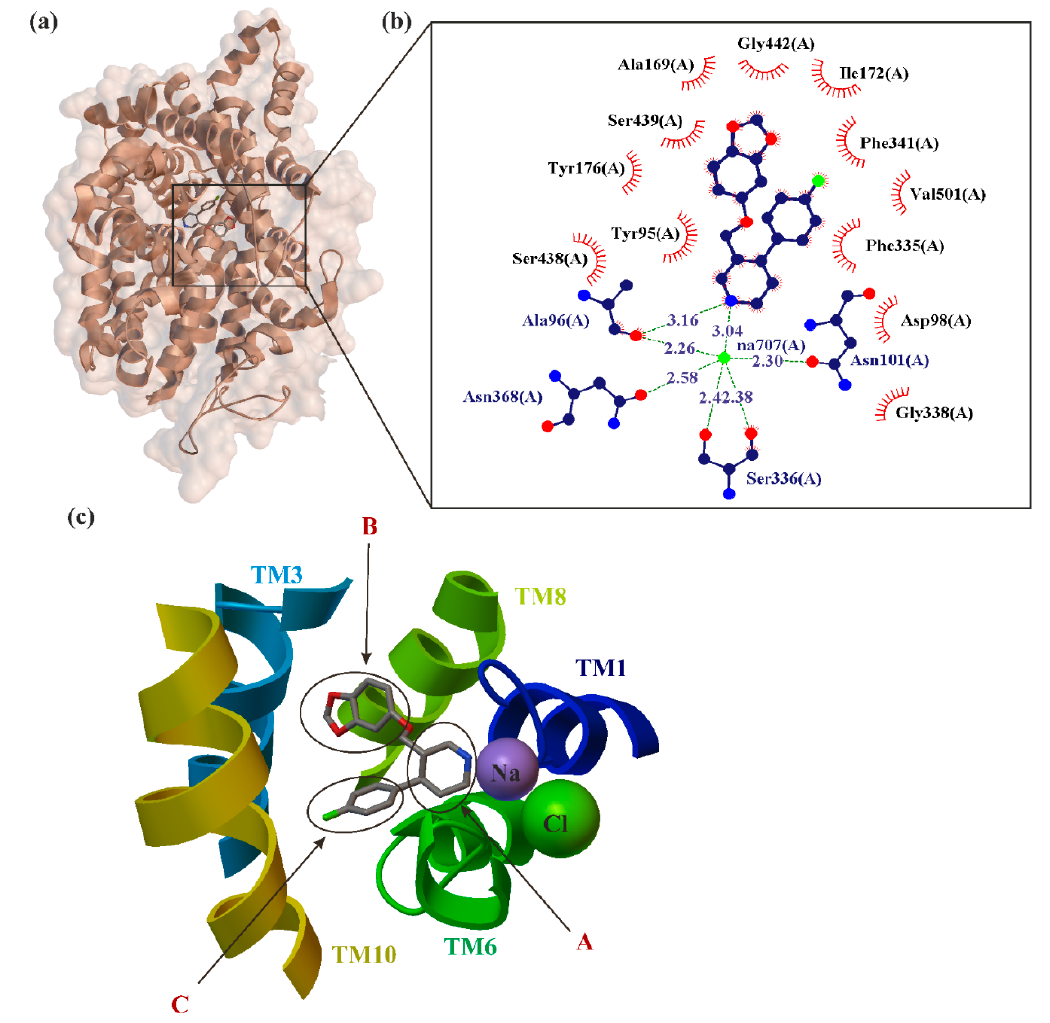
Figure 3. X-ray structure of paroxetine bind in the binding site of the serotonin transporter (SERT) crystal ( a ) with the enlarged area showing the structural elements around the ligand-biding site (PDB ID: 5i6x, 3.14 Å) [52]. Residues that form hydrogen bonds (dashed lines) with paroxetine are shown in ball-and-stick representation with the interatomic distances shown in Å. Residues forming Van der Waals interactions with paroxetine are shown as labeled arcs with radial spokes that point toward the ligand atoms ( b ). Schematic representation of drug interactions in the primary binding pocket of SERT ( c ) [54].